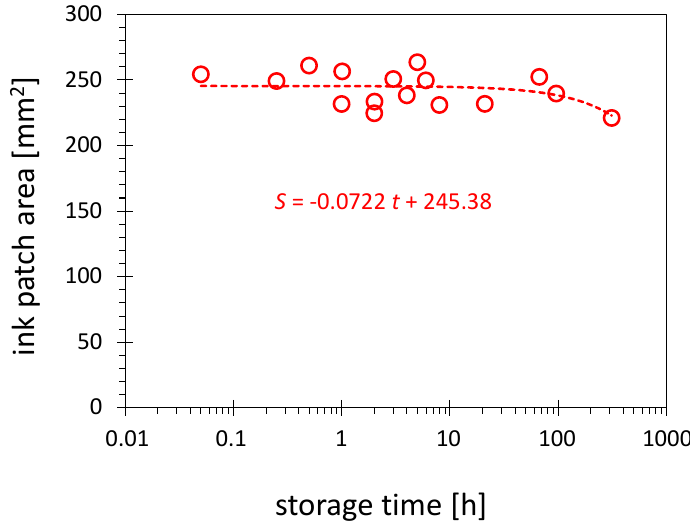
Figure 10. Influence of the storage time on the activation area. The plasma treatment of HDPE substrates was conducted in configuration D and visualized with the 58 mN/m test